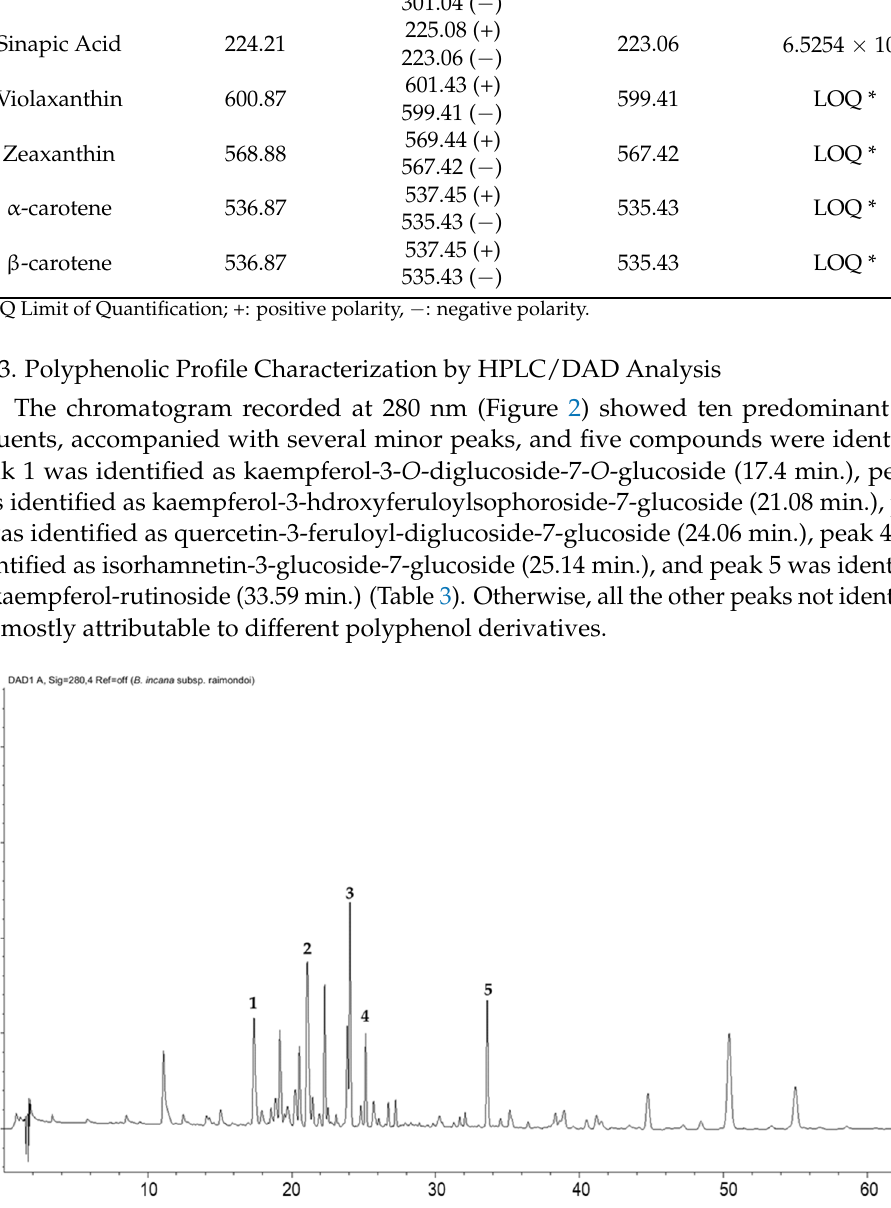
Figure 2. HPLC-DAD polyphenols fingerprint of Brassica raimondoi leaf extract (mAU - milli-